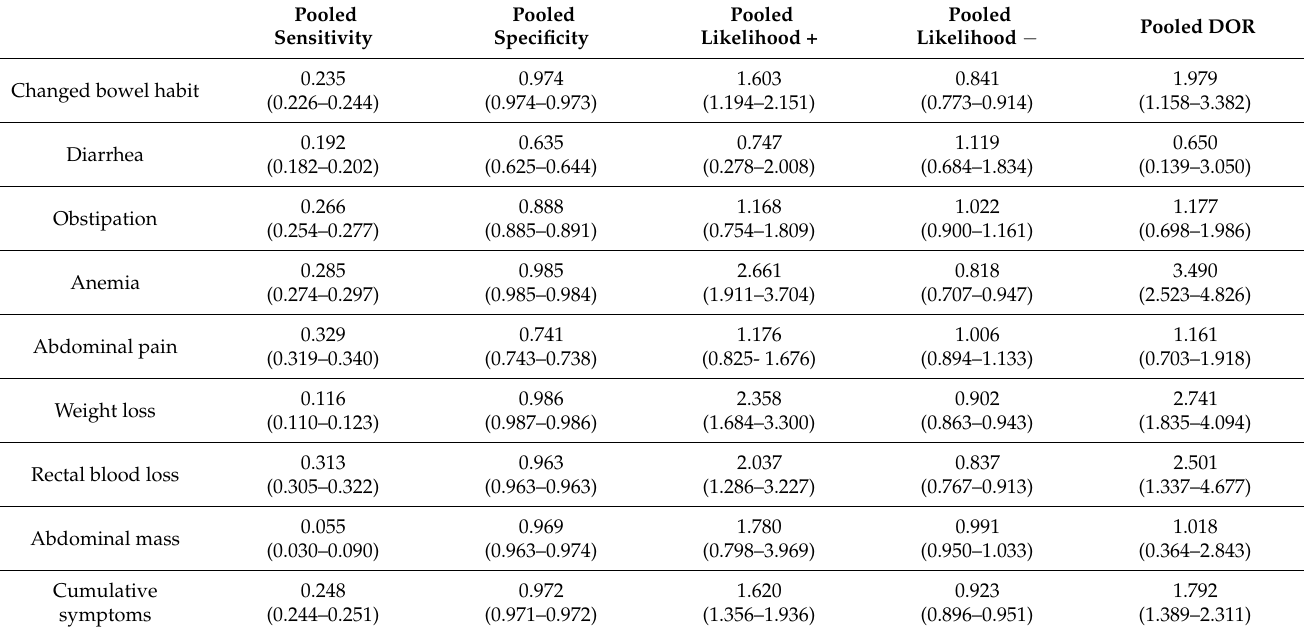
Table 2. The pooled sensitivity, specificity, positive and negative likelihood and diagnostic odds ratio of the studied symptoms.